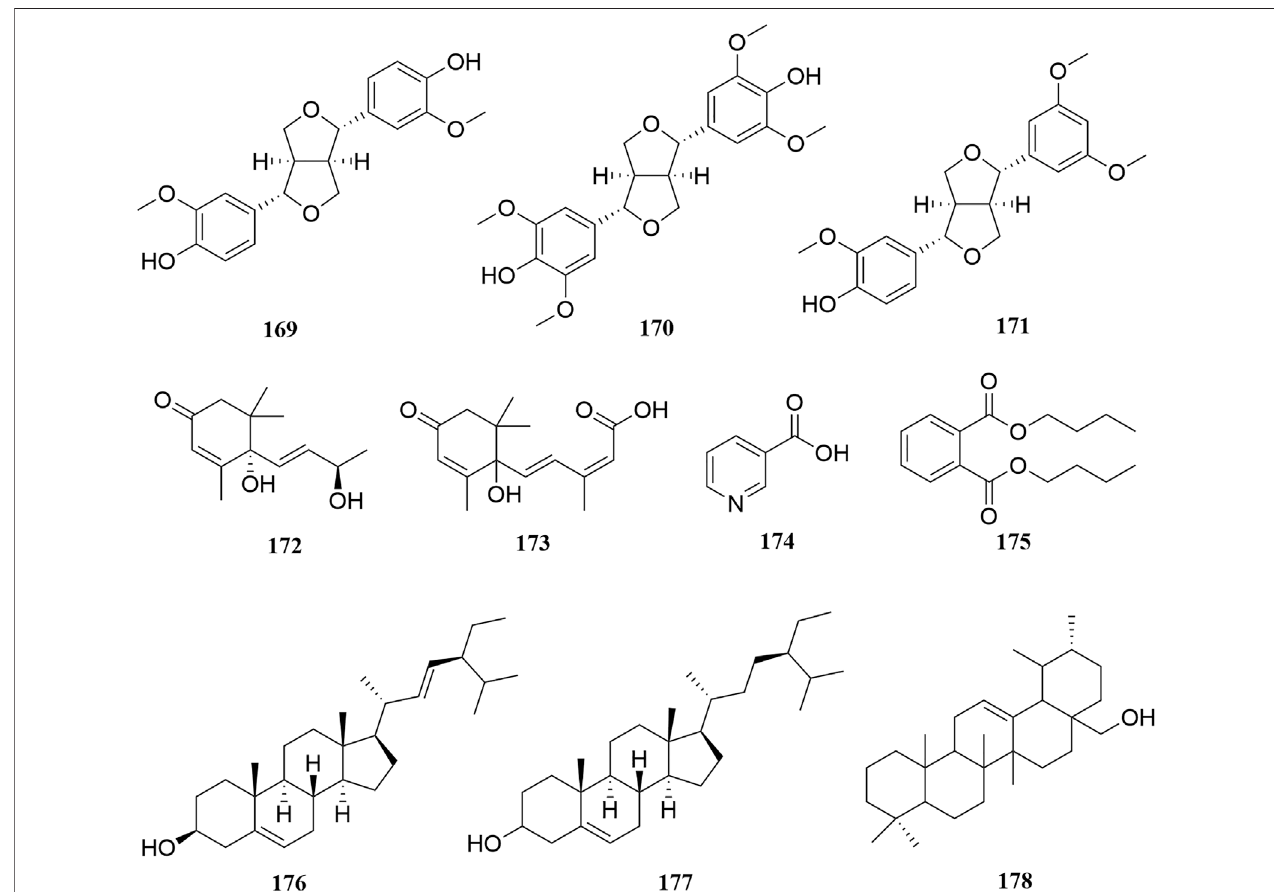
FIGURE 8 | Chemical structures of other constituents ( 169 – 178